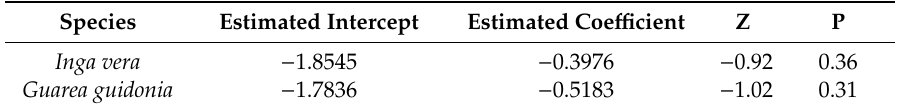
Table 5. Generalized linear mixed model (GLMM) estimates of the association between infestation rate of co ff ee and presence of Inga vera and Guarea guidonia in co ff ee